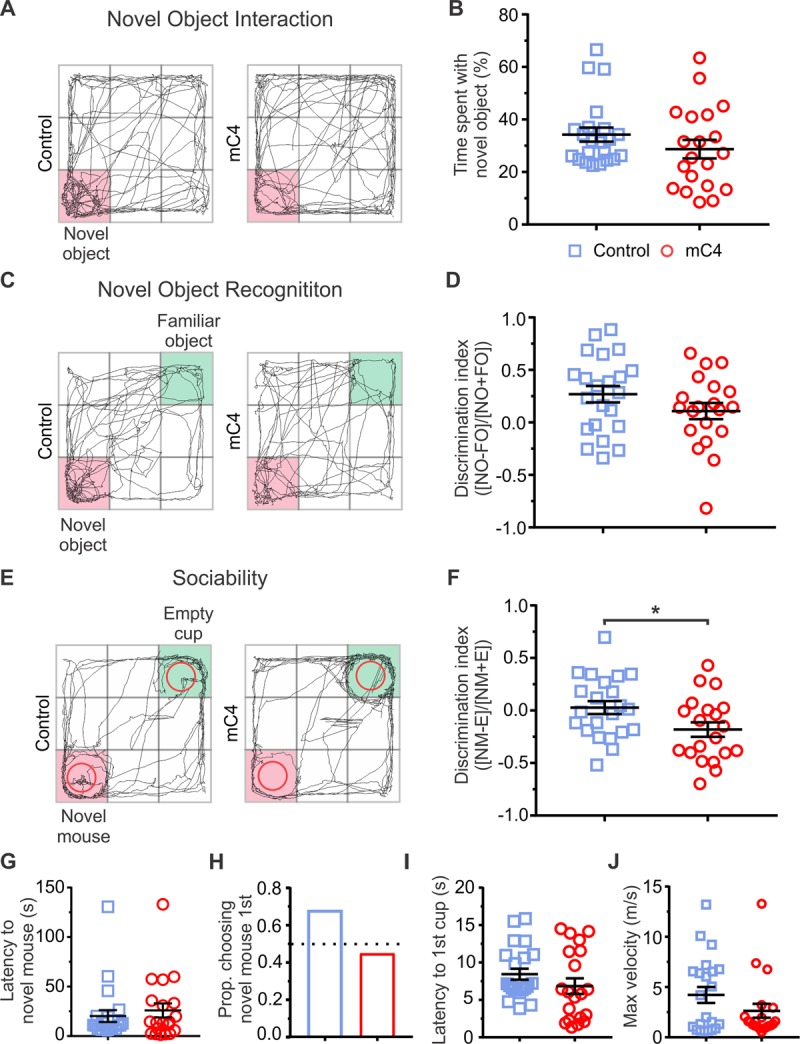
C4-dependent alterations in frontal cortical circuitry led to behavior deficits in sociability that persist into adulthood.(A) Representative examples of path traveled (black trace) by P60 control (left) and mC4 (right) adult mice in NO interaction task. Pink corner = location of NO. (B) Control and mC4 mice spent a similar amount of time exploring the NO. Percent time spent in corner with NO shown. p = 0.2127. (C) Representative examples of path traveled (black trace) by P60 control (left) and mC4 (right) adult mice in NO recognition task. Pink corner: location of NO. Green corner: location of FO. (D) NO recognition was intact in the mC4 condition. Control and mC4 mice had a similar DI ([time with NO − time with FO] / (time with NO + time with FO]). p = 0.1539. (E) Representative examples of path traveled (black trace) by P60 control (left) and mC4 (right) adult mice in sociability task. Pink corner: location of novel mouse under mesh wire cup. Green corner: location of empty mesh wire cup. (F) mC4-overexpressing mice spent less time exploring a novel mouse and more time with the empty cup (“E”) relative to control. Graph shows DI ([time with novel mouse–time with empty cup] / [time with novel mouse + time with empty cup]). *p = 0.029. (G) Control and mC4 mice had a similar latency to first approach the novel mouse (sec). p = 0.5416. (H) Control and mC4 mice traveled to the novel mouse cup first at a similar proportion. Proportion (“Prop.”) of mice that approached the novel mouse cup first. Fisher’s exact test. p = 0.54. (I) Latency to reach first cup (either novel mouse cup or empty cup) was not different (sec) between conditions. p = 0.217. (J) Control and mC4 mice reached the same maximum velocity (m/s). p = 0.1442. N = 22 control and N = 20 mC4 mice between P60 and 70. Blue: control. Red: mC4. t test unless otherwise stated. Mean ± SEM unless otherwise noted. For underlying data and script (respectively), see https://osf.io/7em3s/?view_only=0e7ffde4ebd344dc83af83b5a605c451 and https://github.com/balajisriram/dlc_utils. DI, discrimination index; FO, familiar object; mC4, mouse C4; NO, novel object; P, postnatal day.